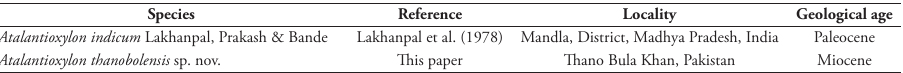
Table 2. Geographical and stratigraphical data of fossils related to the genus Atalantioxylon .